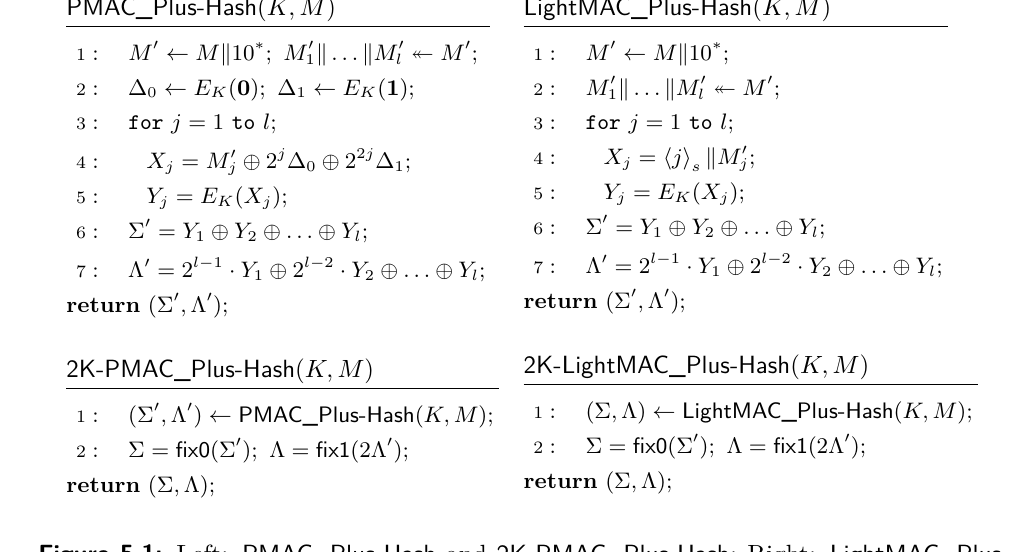
Figure 5.1: Left: PMAC_Plus-Hash and 2K-PMAC_Plus-Hash ; Right: LightMAC_Plus- Hash and 2K-LightMAC_Plus-Hash with s -bit counter. M 0